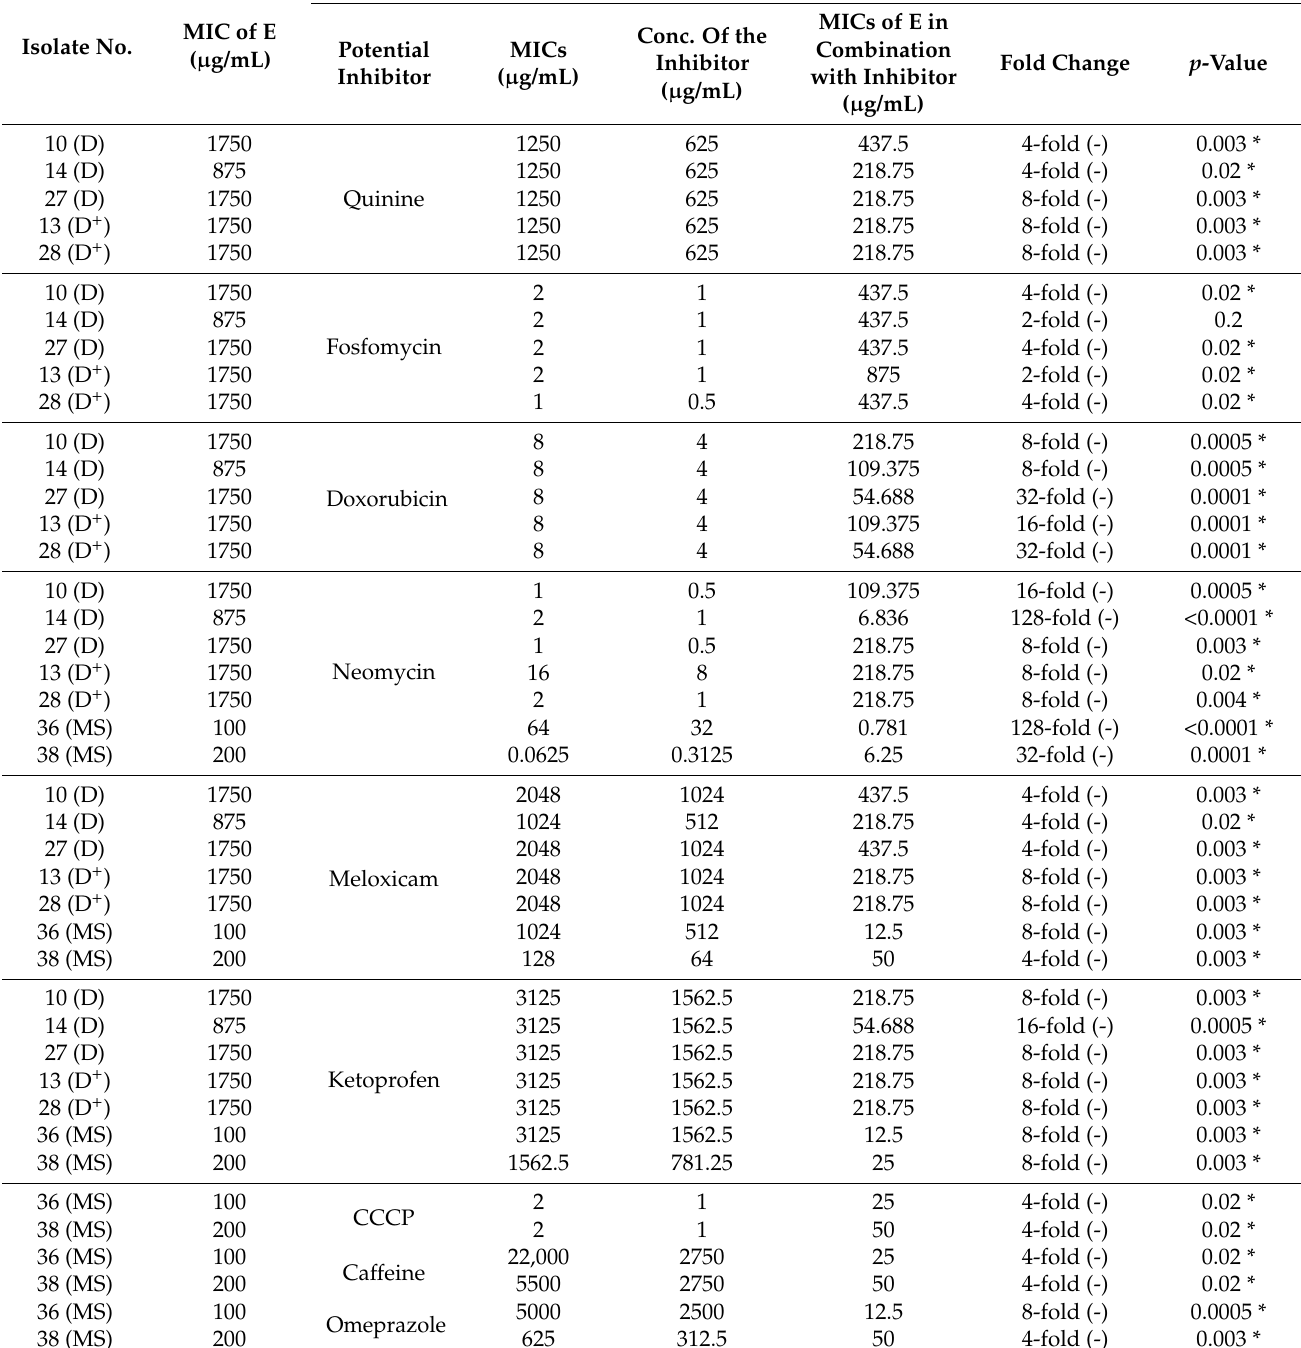
Table 2. Effect of potential inhibitors on erythromycin resistance against S. aureus isolates no. 10, 14, and 27 (D phenotype), isolates no. 13 and 28 (D + phenotype), and isolates no. 36 and 38 (MS